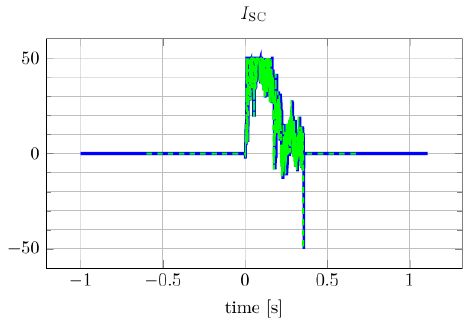
Figure 6. Current reference of the Saddle Coil [A] produced by the reviewed axisymmetric system (dashed) obtained by feeding the system with waveforms from previous experiments compared with the experimental outputs.